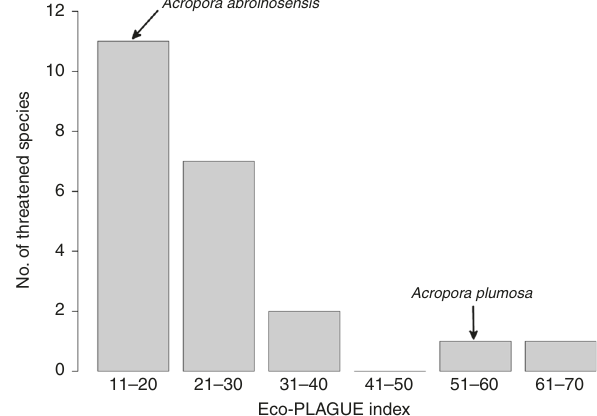
Fig. 2 Local priority-setting may allow global coral PD loss. This histogram summarises the extent to which local (within-ecosystem) priority setting for 94 threatened Acropora corals allows possible consequent global